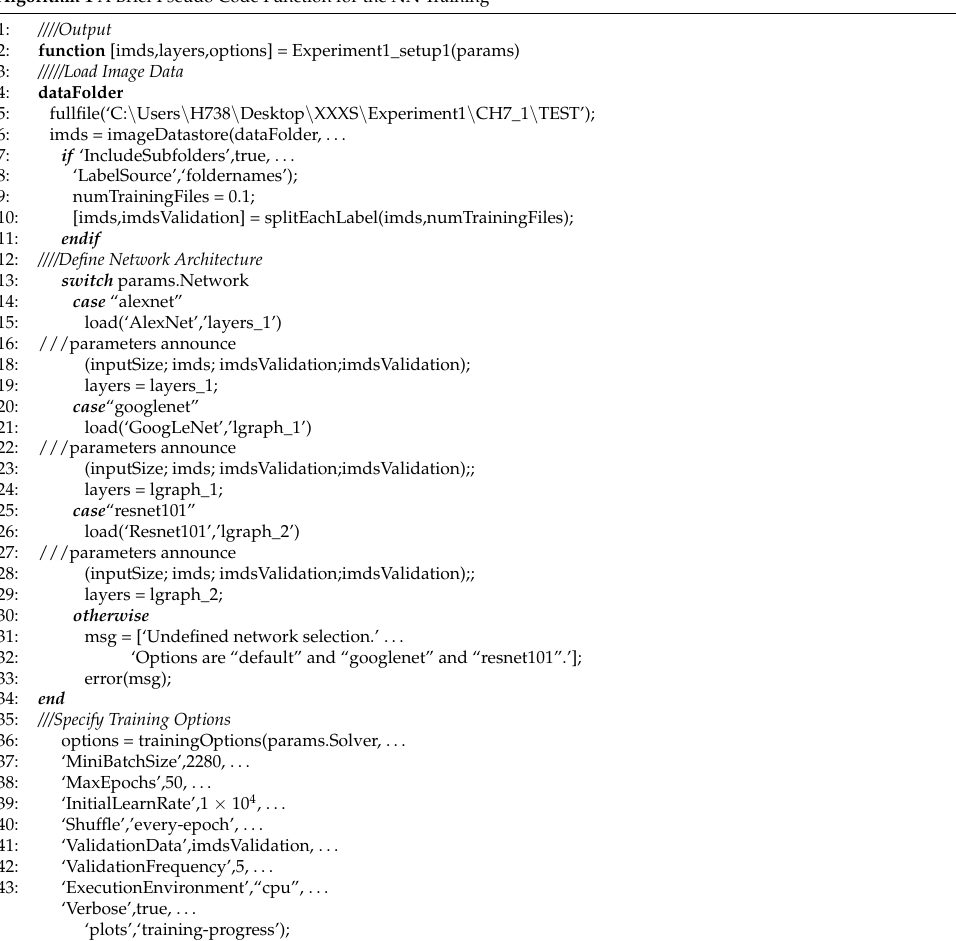
Algorithm 1 A Brief Pseudo Code Function for the NN